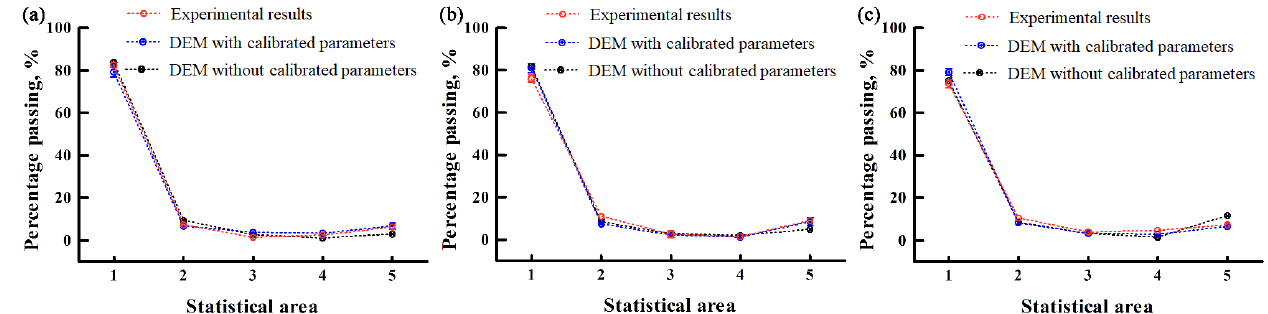
Figure 21. Comparisons of the simulation results with the test results of the percentage passing from different statistic areas in the “self - flow screening” for ( a ) SN42, ( b ) JD17, and ( c ) ZD39. Further analysis of the percentage passing of the simulation and experimental re- sults for the three varieties is shown in Figure 22.